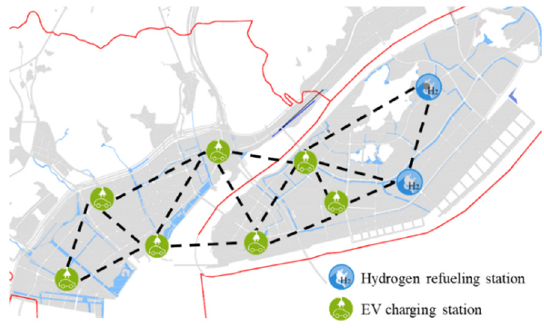
Figure 14. The layout of charging infrastructures.